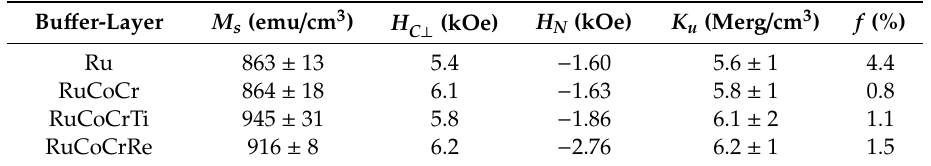
Table 1. Magnetic parameters obtained from room temperature out-of-plane field dependent magnetization loops. M s saturation of magnetization; H C ⊥ : out-of-plane coercivity; H N : nucleation filed; K u : anisotropy constant; f : lattice